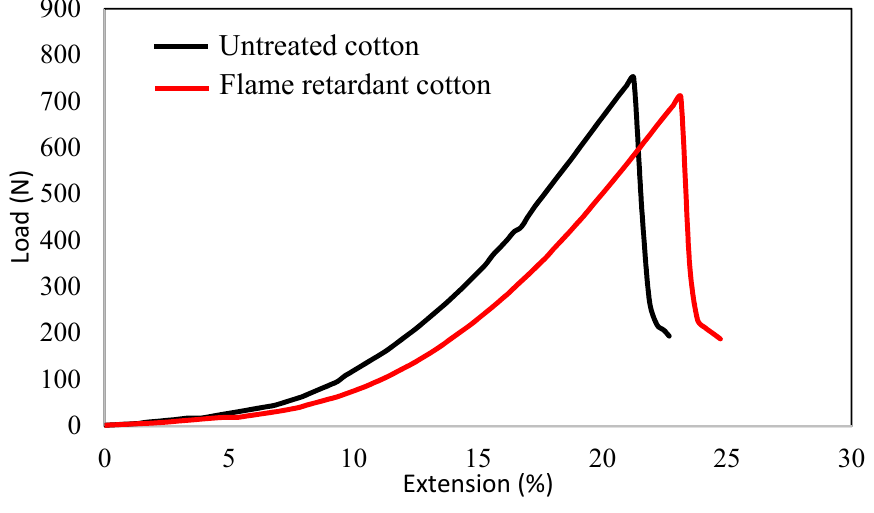
Figure 6. Load–extension curves of cotton fabrics. Table 1. Tensile characteristic parameters.